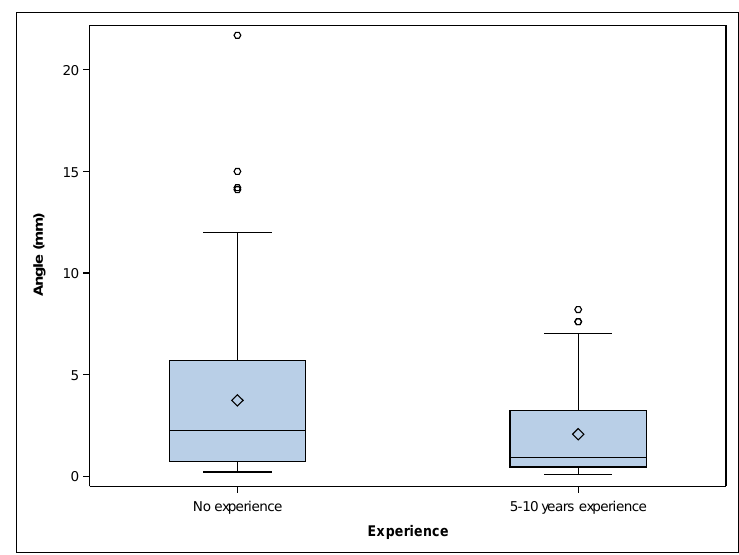
Figure 5. Box plots of angular deviations of the experimental groups. The horizontal line in each box represents the median value.